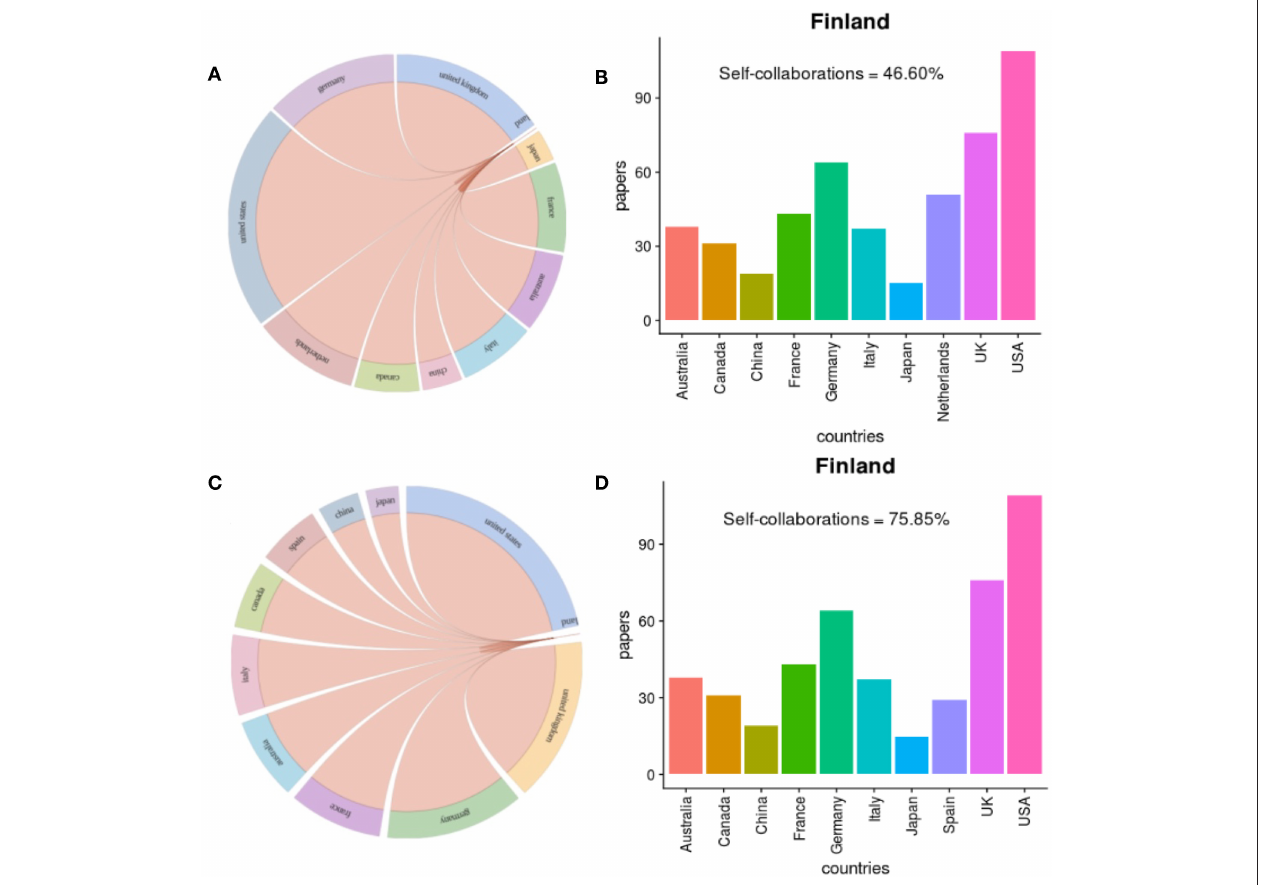
FIGURE 6 | Collaborations between Finland and top 10 countries in prostate cancer research. (A,B) show results about prostate cancer research in general and (C,D) about prostate cancer research in genetics.